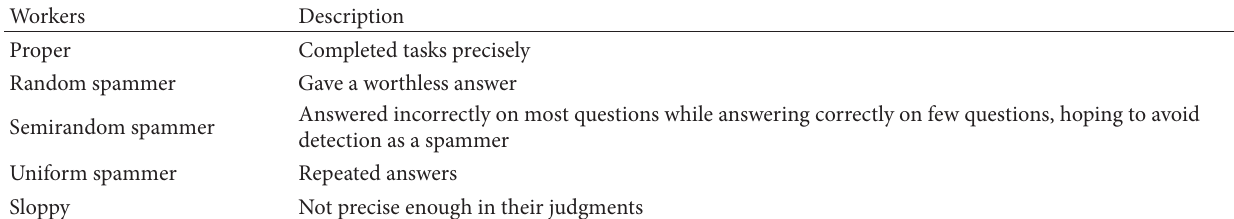
Table 5: Worker types based on their average